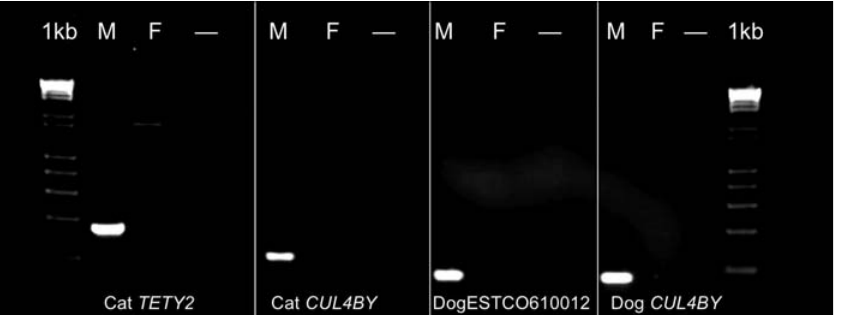
Figure 4. Male-Specific Amplification of TETY2 and CUL4BY STS Primers in Cat and Dog A fragment of both genes has been PCR amplified with Y chromosome STS markers in matched cat and dog male and female genomic DNA samples. A 1-kilobase (kb) DNA ladder is shown to the left and right. PCR products are of the expected size in male DNAs, whereas no or nonspecific amplification is observed in female DNAs. The third lane in each set of primers ( (cid:2) ) is a no-DNA control reaction. Dog ESTCO610012 is orthologous to cat TETY2. DOI: